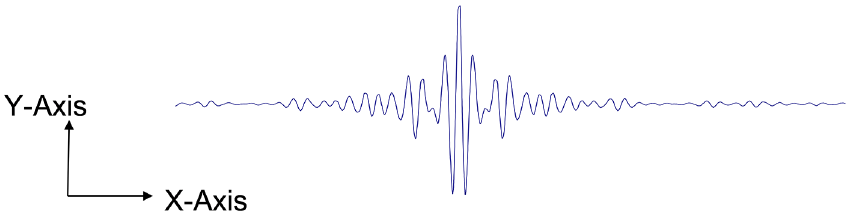
Figure 8. Corrections in the Level 1 B processing in the interferogram domain. V050, V110, V130, V150, V161, and V201 are versions of the Level 1B. The items with italic letters are described in this paper. X axis (re-sampling): (1) FTS mechnism scan speed instability correction for medium gain (2 sinusoidal sources) (V110 and later); (2) sampling interval non-uniformity correction (SINUC) (V150 issue, not applied in V161, modified in V201) ; (3) analogue circuit intensity dependent phase delay correction (V201) ; (4) Doppler shift due to image motion compensation (forward to backward viewing) (not corrected). Y axis (intensity correction): (1) intensity variation (low frequency) component correction (V050, modified in V201) ; (2) Band 4 detector nonlinearity correction (V110 and later, to be modified in the next version); (3) Band 1 high gain amplifier nonlinearity correction (V150, modified in V201) ; (4) ADC nonlinearity (not corrected, V130